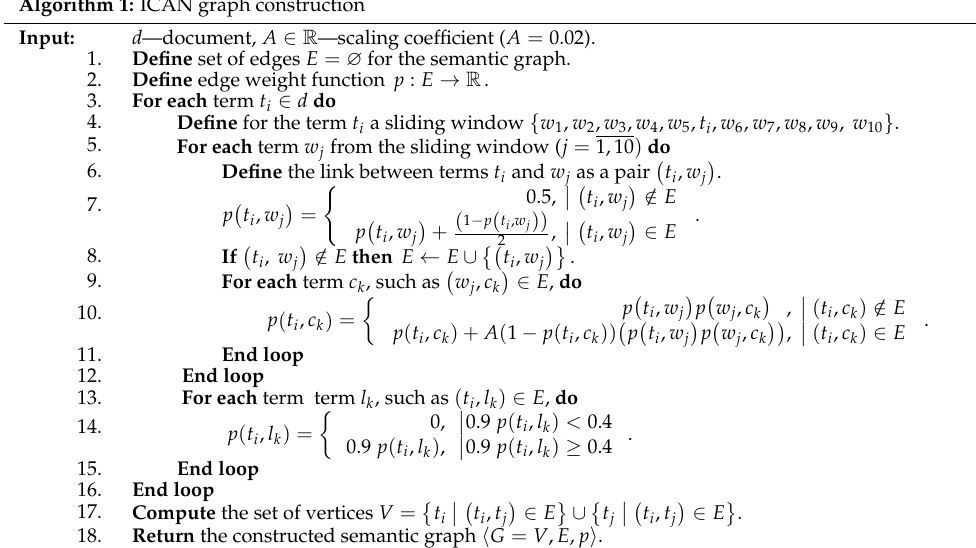
Algorithm 1: ICAN graph